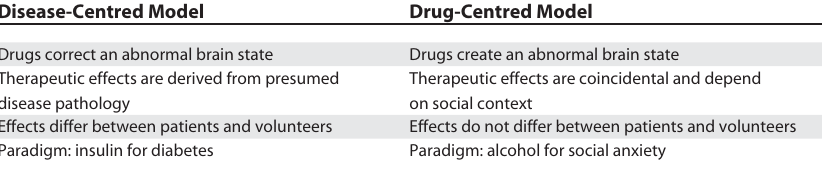
Table 1. Main Assumptions of Two Models of Psychotropic Drug